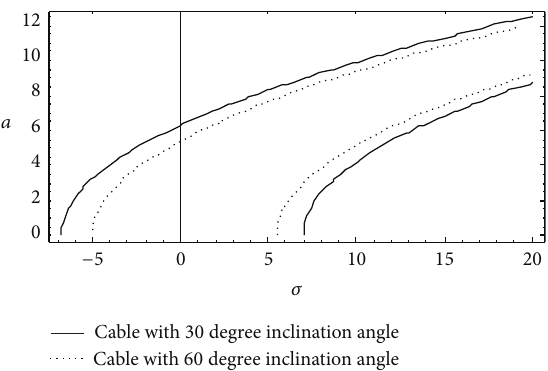
Figure 2: Frequency-amplitude curves with various inclination angles of the cables.